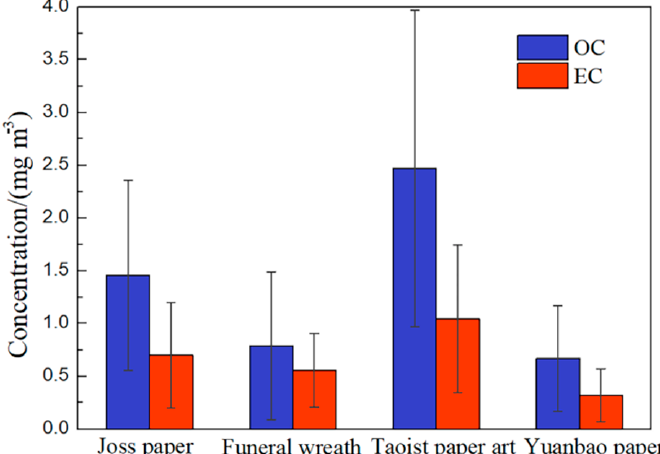
Figure 8. Concentrations of EC and OC in PM 2.5 generated from the incineration of sacrificial offerings.